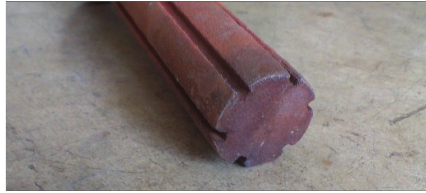
Figure 4: Copper powder sintered wick structure.